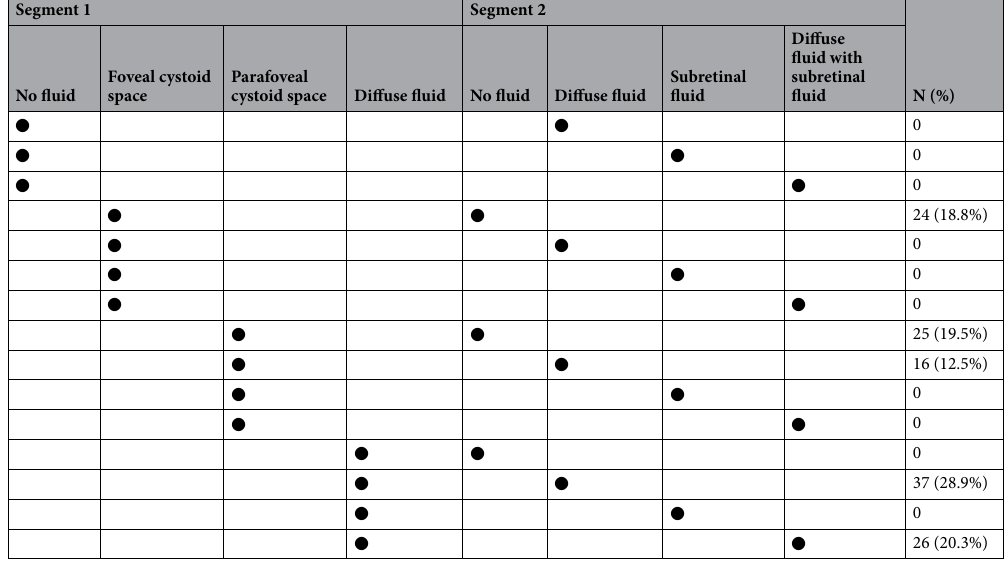
Table 1. Classification of diabetic macular edema based on en face